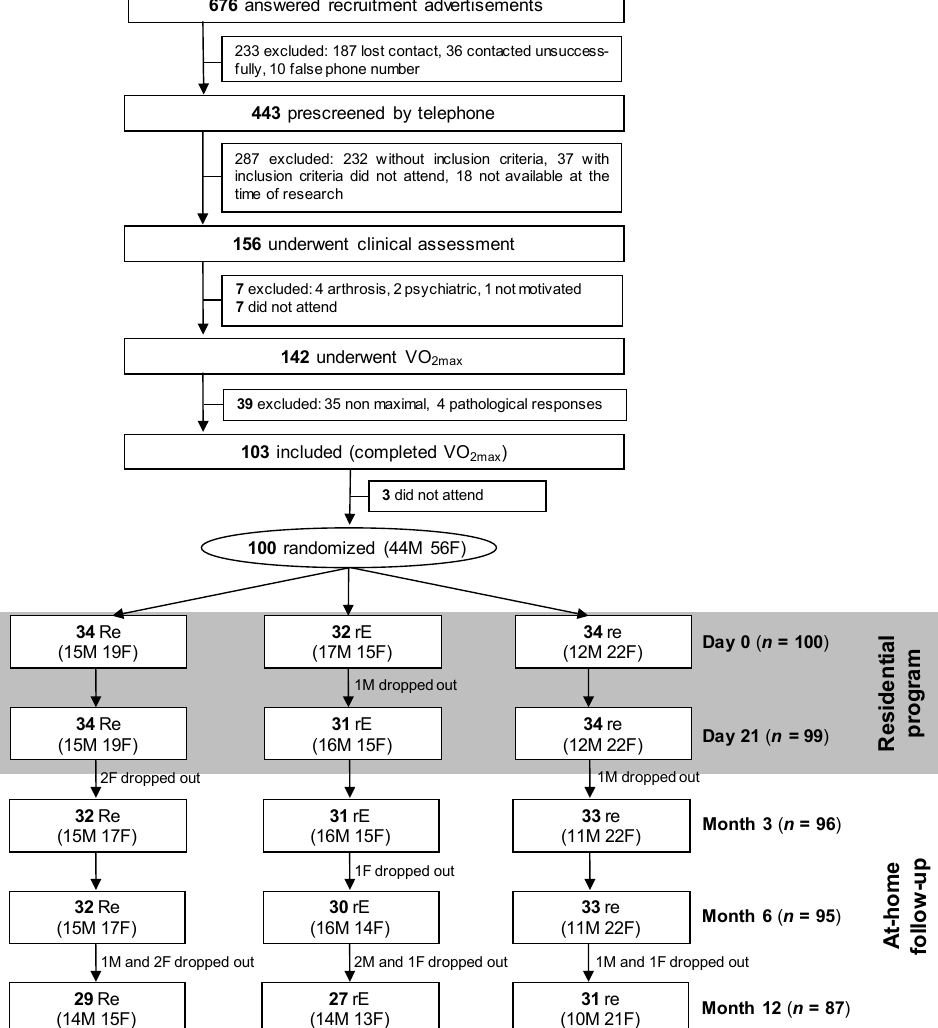
Figure 1. Flow chart. VO 2max = maximal oxygen uptake; Re, rE and re: see methods for details; M = males; F = females.